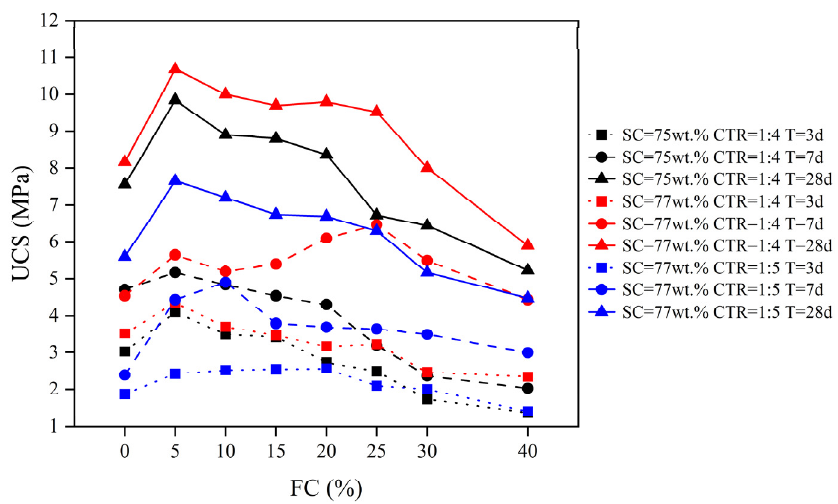
Figure 11. Relationship between the FC and the UCS of the FCPB.